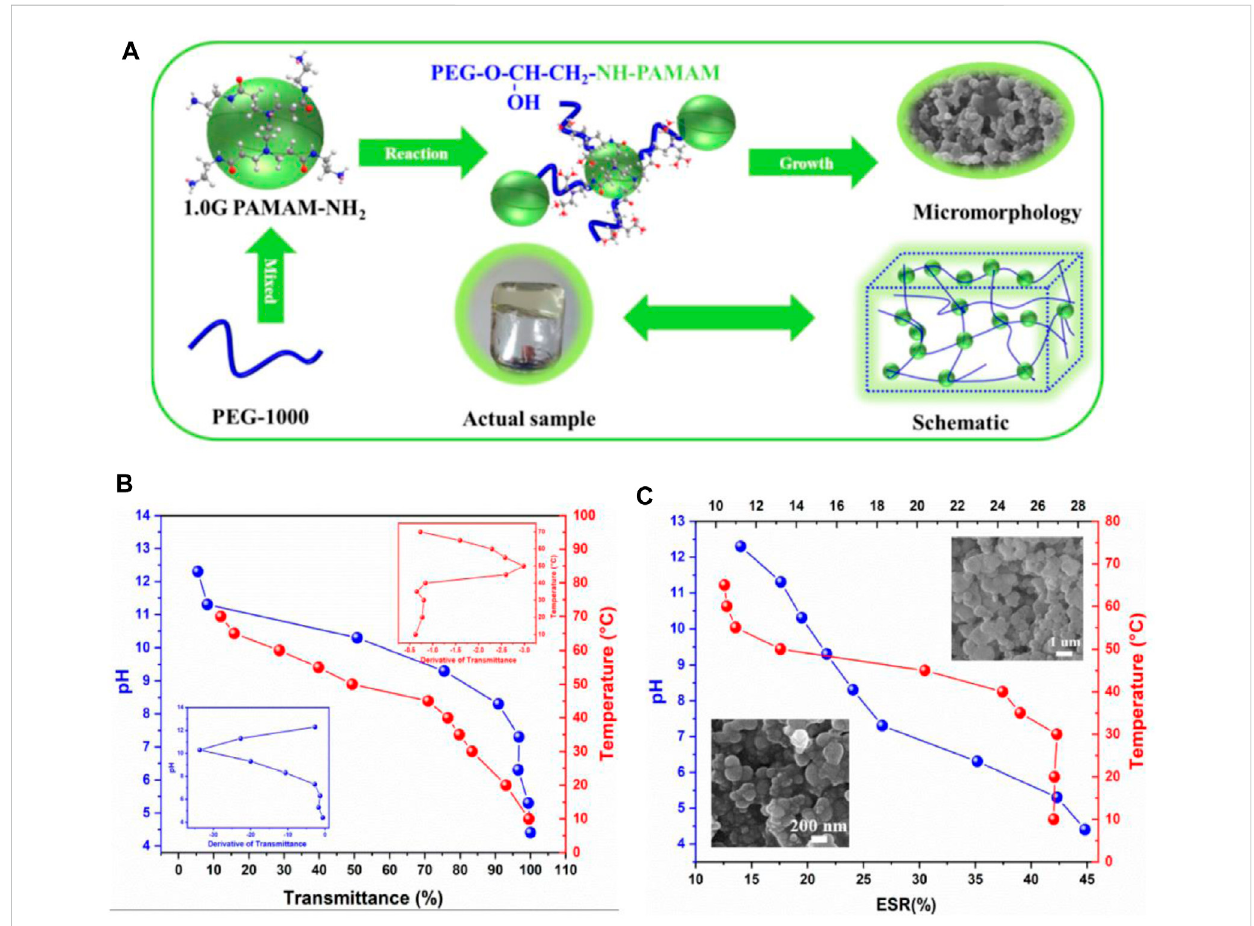
FIGURE 5 (A) Diagram of PEG/PAMAM hydrogel gelation. (B) Transmittance and phase transition temperature and pH curves of PEG/PAMAM hydrogels. (C) Equilibrium swelling ratio curves of PEG/PAMAM hydrogels under different temperatures and pHs (Liu X. et al., 2022).